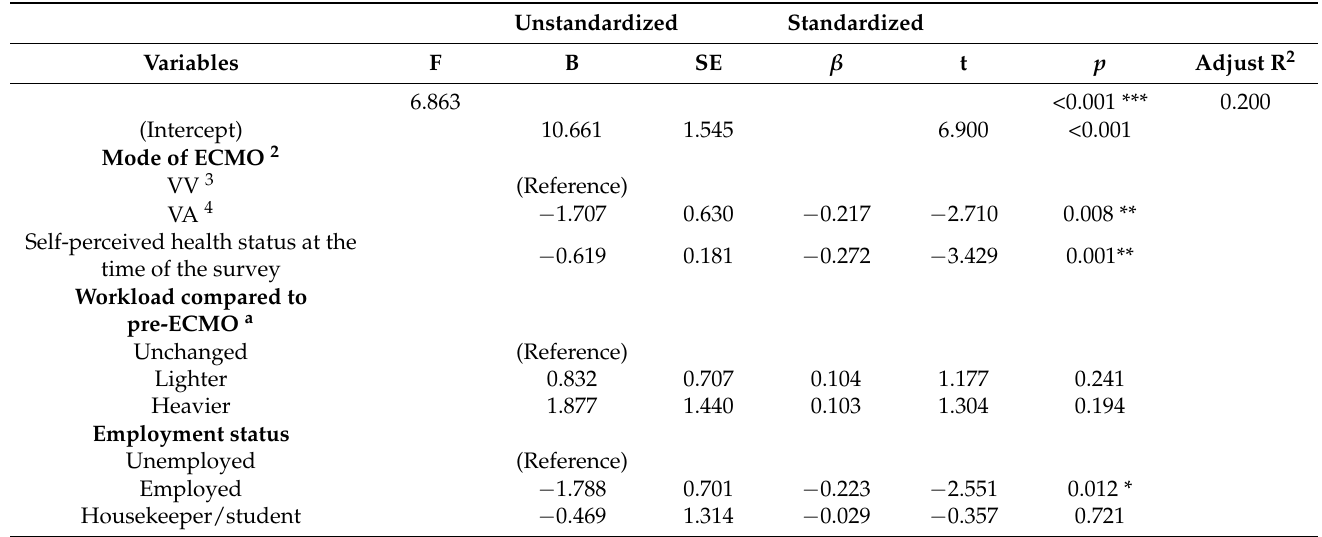
Table 3. Predictors of depression (HADS-D 1 score) for survivors of ECMO after hospital discharge ( N =